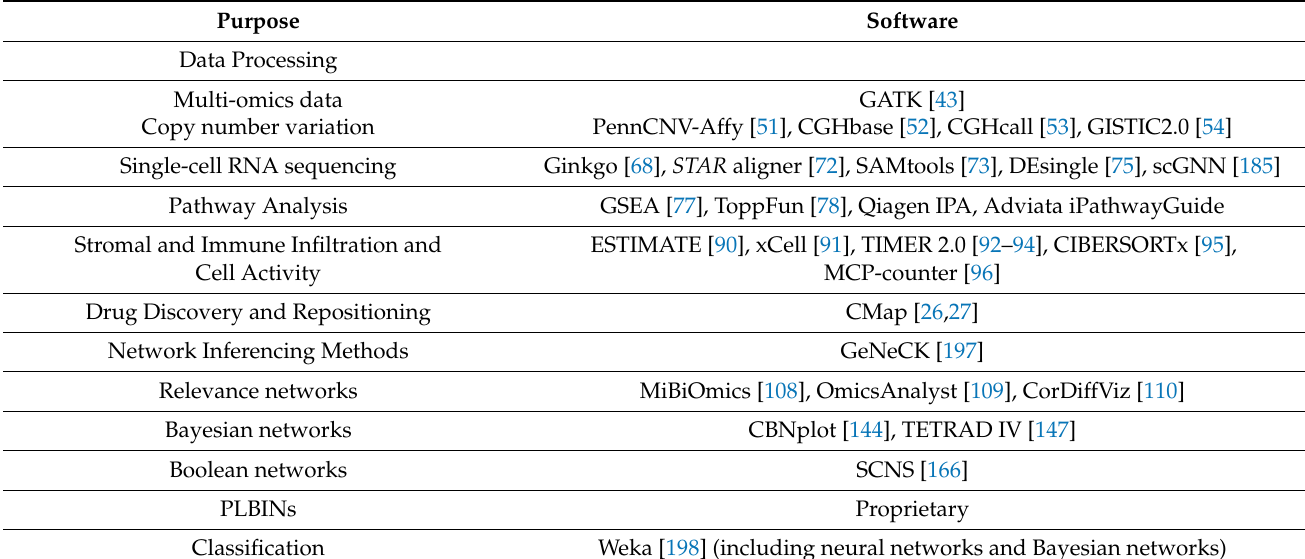
Table 1. Summary of software for multi-omics data processing, pathway analysis, and network inferencing in bulk tumors and single